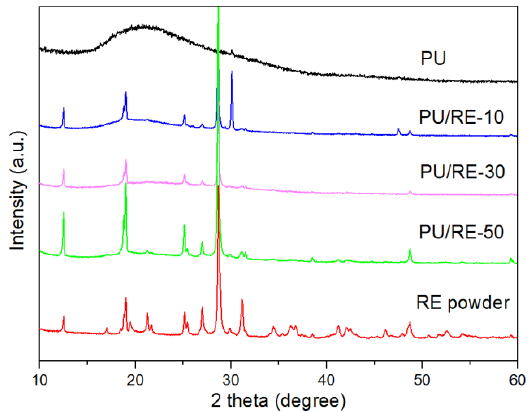
Figure 5. X-ray diffraction (XRD) patterns of different PU/RE nanofibrous mats.